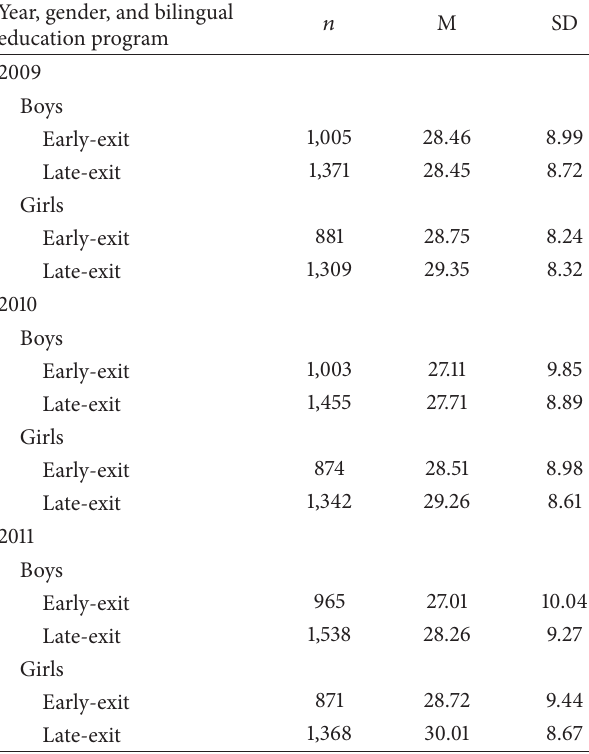
Table 4: Descriptive statistics for the 2009, 2010, and 2011 TAKS Reading scores for Grade 6 boys and girls by bilingual education